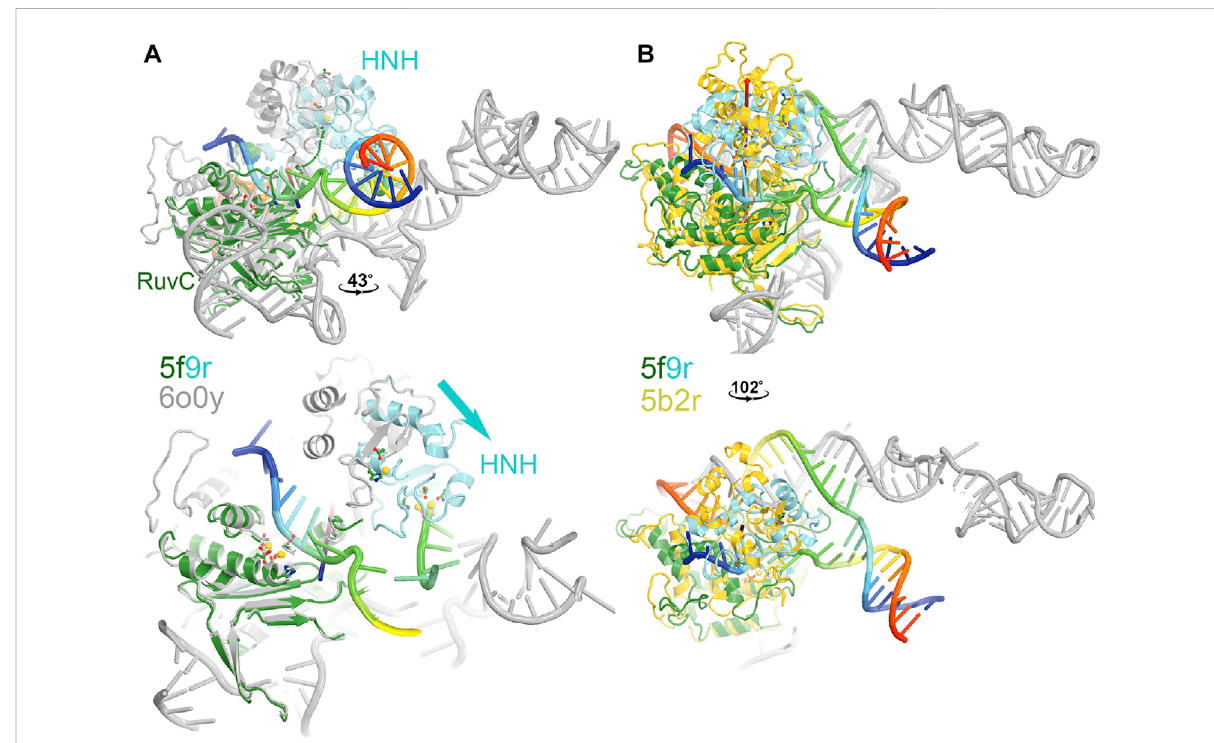
FIGURE 3 Two views of HNH domain rotations. (A) Between the RuvC and HNH catalytically relevant complexes of 5f9r and 6o0y. (B) Between the RuvC catalytically relevant and its inactive complexes of 5f9r and 5b2r. See supporting information for animation videos of the domain rotations (Supplementary Video